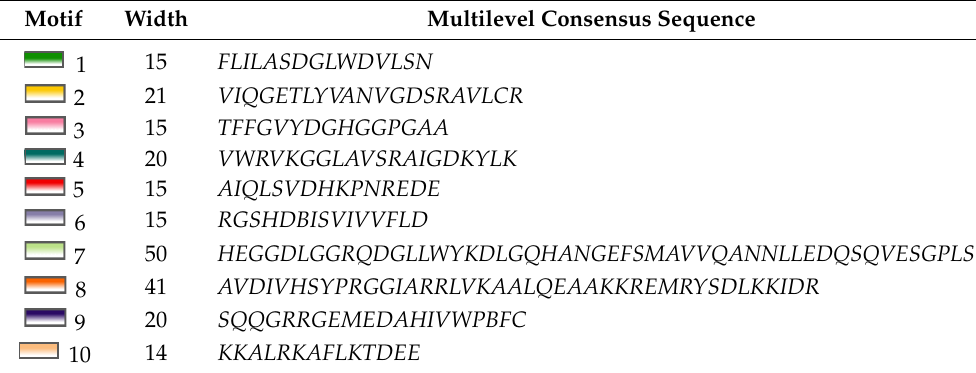
Table 4. Conserved motifs in the amino acid sequences of SlPP2C proteins.